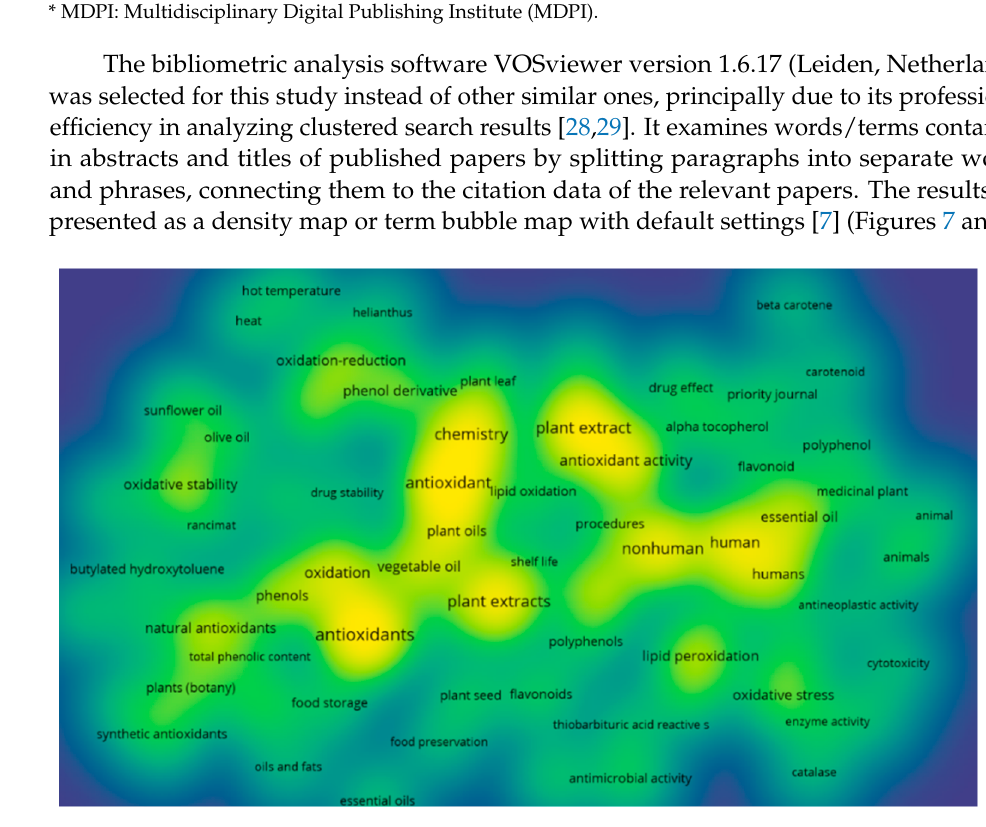
Figure 7. Density map of clusters based on Scopus database performed via VOSviewer software.